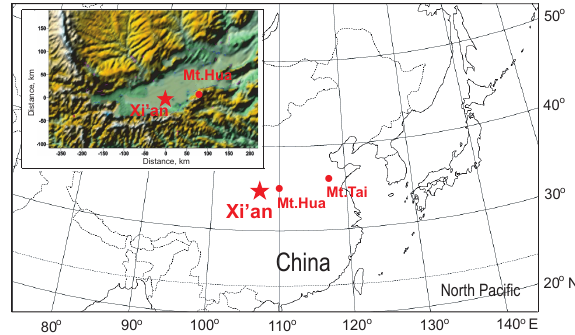
Fig. 1. A map description for Xi’an city and Mt. Hua in Guanzhong Figure 1 A map discription for Xi’an city and Mt. Hua in Guanzhong Basin, inland China Basin, central China (inserted figure showing the topography of and Mt.Tai in east China (inserted figure showing the topography of Guanzhong Basin) Guanzhong